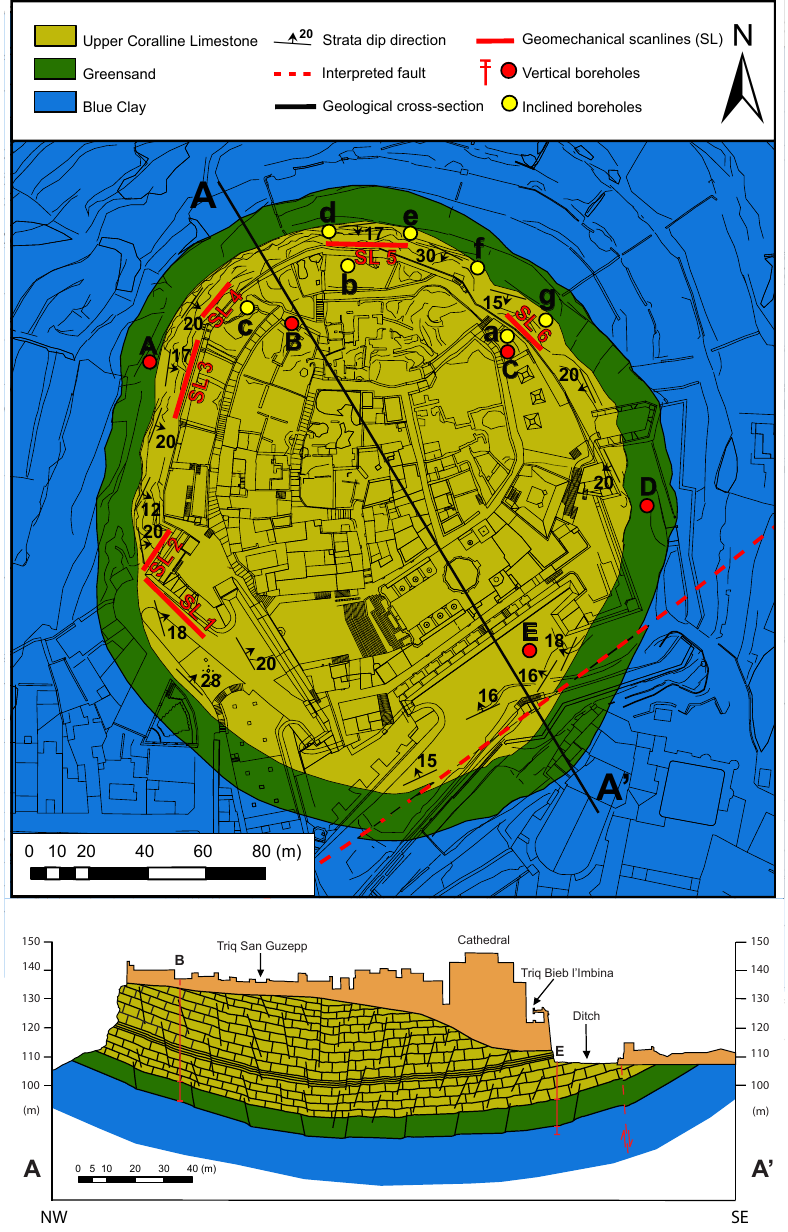
Fig. 7. Geological map and cross-section of Citadel.